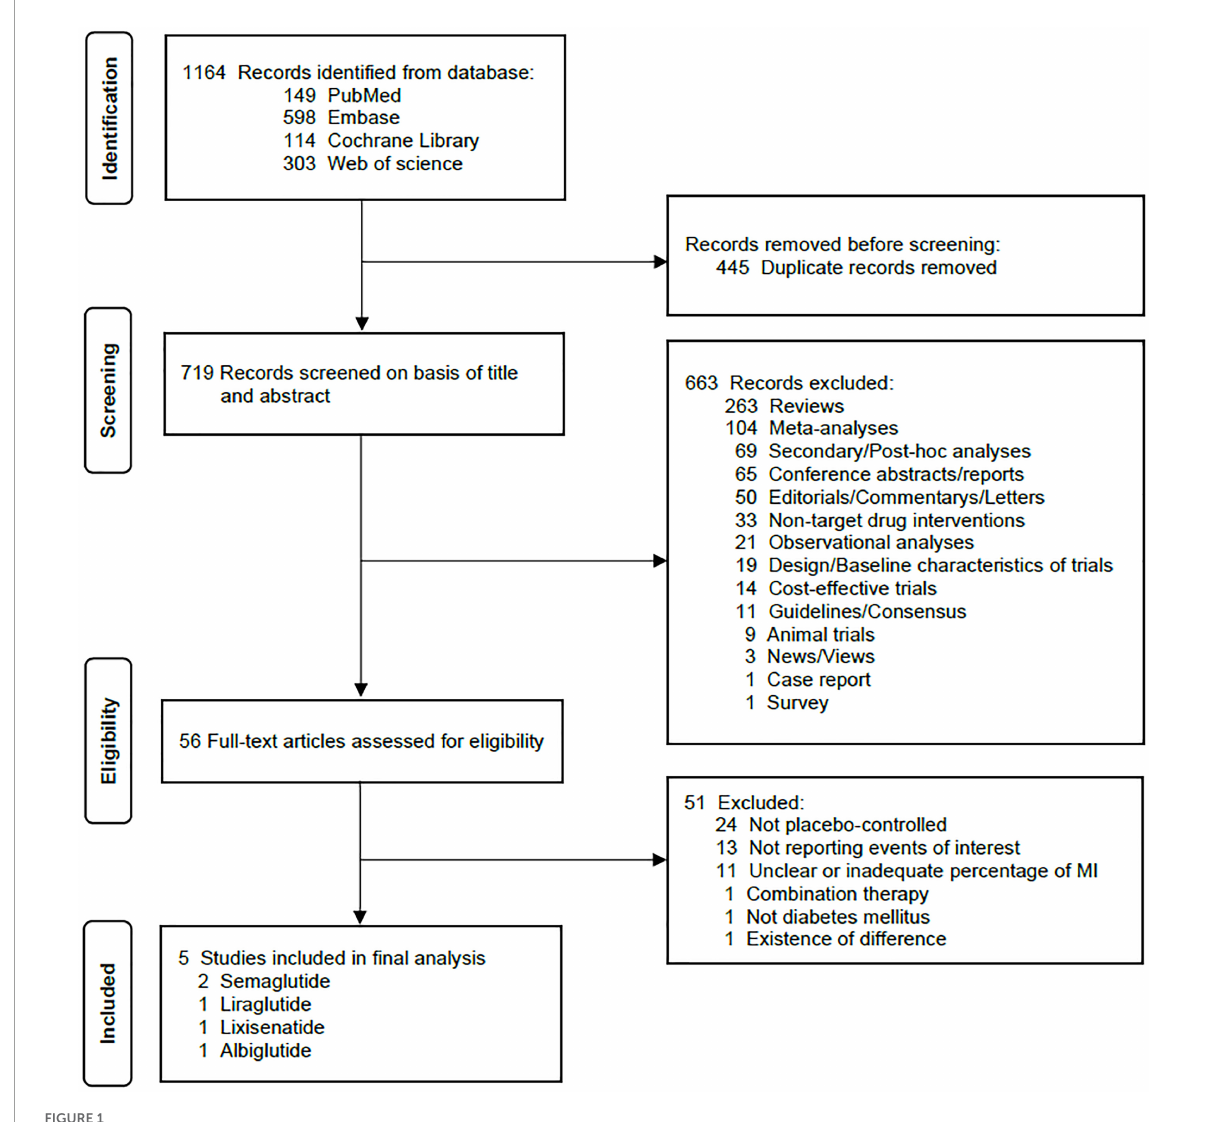
FIGURE1 PRISMA flow diagram of study selection. MI, myocardial infarction.